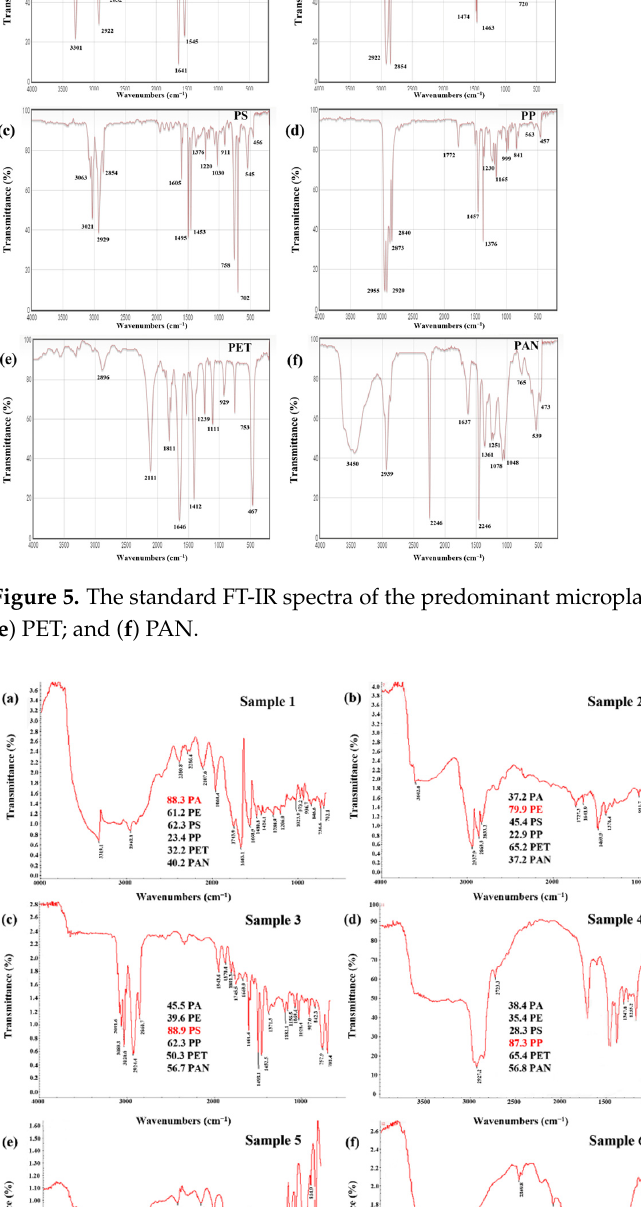
Figure 7. ( a ) Micrographs of the predominant microplastics; ( b ) the proportions of various micro- plastic types found during different seasons in the Pearl River Delta. Note: PA, polyamide; PE, pol- yethylene; PS, polystyrene; PP, polypropylene; PET, polyethylene terephthalate; and PAN, polyac- rylonitrile. 3.4. The Correlation Analysis of the Socio-Economic Indicators and MP Abundances Three major socio-economic indicators were applied to investigate the potential rela- tionships between MP abundances and human social and economic activities [35,36]. The three socio-economic indicators used in our study were the population density (hundred person/km 2 ), the degree of afforestation, and the degree of industrialization and traffic density. The variations in the three above-mentioned socio-economic indicators of the se- lected 13 sampling sites had varying degrees of correlation with the abundances of MPs (Figure 8). Figure 9 showed the Pearson correlation analysis between MP abundances and the three socio-economic indicators used in our study, namely, population density, the degree of afforestation, and the degree of industrialization and traffic density. Firstly, the statis- tical and correlation analyses showed that MP abundances in the surface water had no significant correlation with the changes in population density ( p = 0.116 in the rainy season and p = 0.667 in the dry season). Secondly, Figure 8c,d showed that MP abundances during